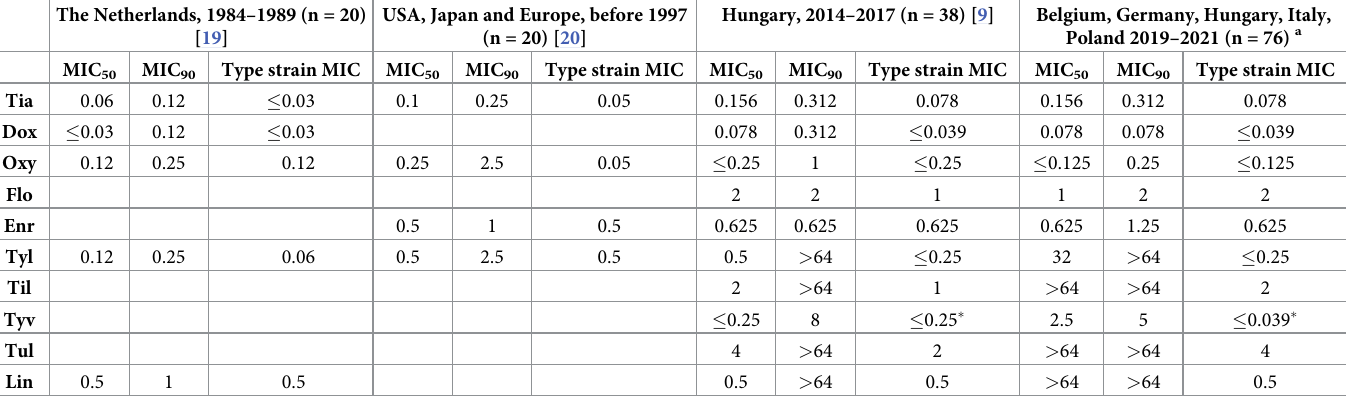
Table 4. Comparison of minimal inhibitory concentrations (MIC) of ten antimicrobial agents from previous publications and the present study. MIC values against